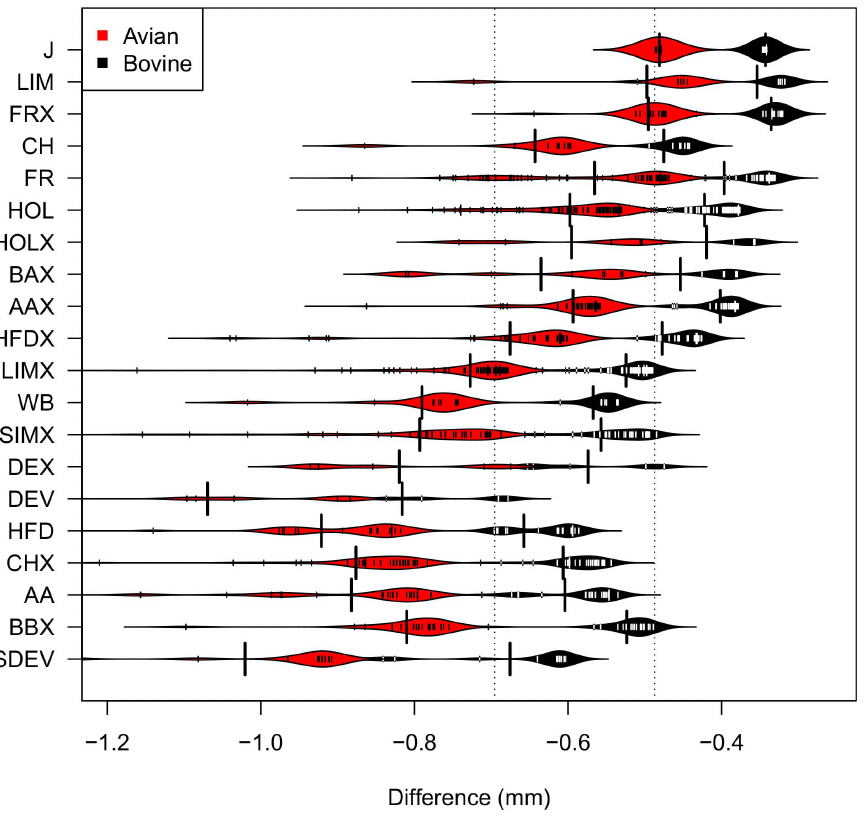
Figure 3. Predicted effect of ‘22’ genotype on second avian ( a2 , red) and second bovine ( b2 , black) measurements. The predicted impact of the ‘22’ parameter (0=not ‘22’, 1=‘22’) on the second avian and second bovine swelling size measurements within our study population is summarised as a ‘beanplot’. The solid envelope represents the smoothed density kernel for the predicted values. Actual values are over-plotted as solid lines and the vertical dotted lines indicate the mean effect sizes across all breeds for the two measurements. Predicted values are calculated from the two Poisson regression models: a2 , p22 + breed + age; b2 , p22 + breed + age (Tables S2, S3).